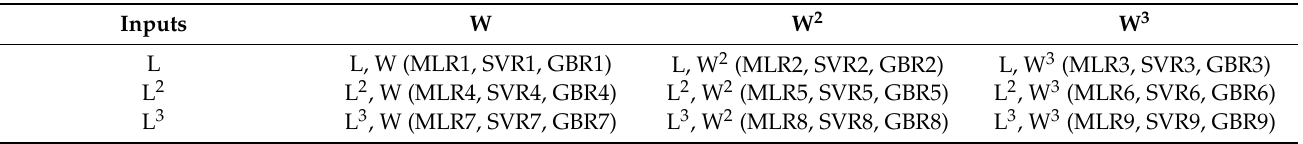
Table 1. Input combinations of L, W, and their variants with model names of MLR, SVR, and GBR.